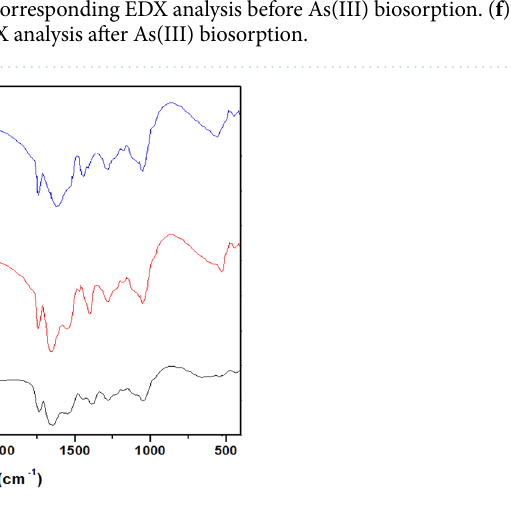
Figure 9. FTIR spectra of untreated fungal biomass (FFB, lower, black line) and Iron-impregnated immobilized fungal biomass (IIFB) before As(III) biosorption (middle, red line) and after As(III) biosorption (upper, blue